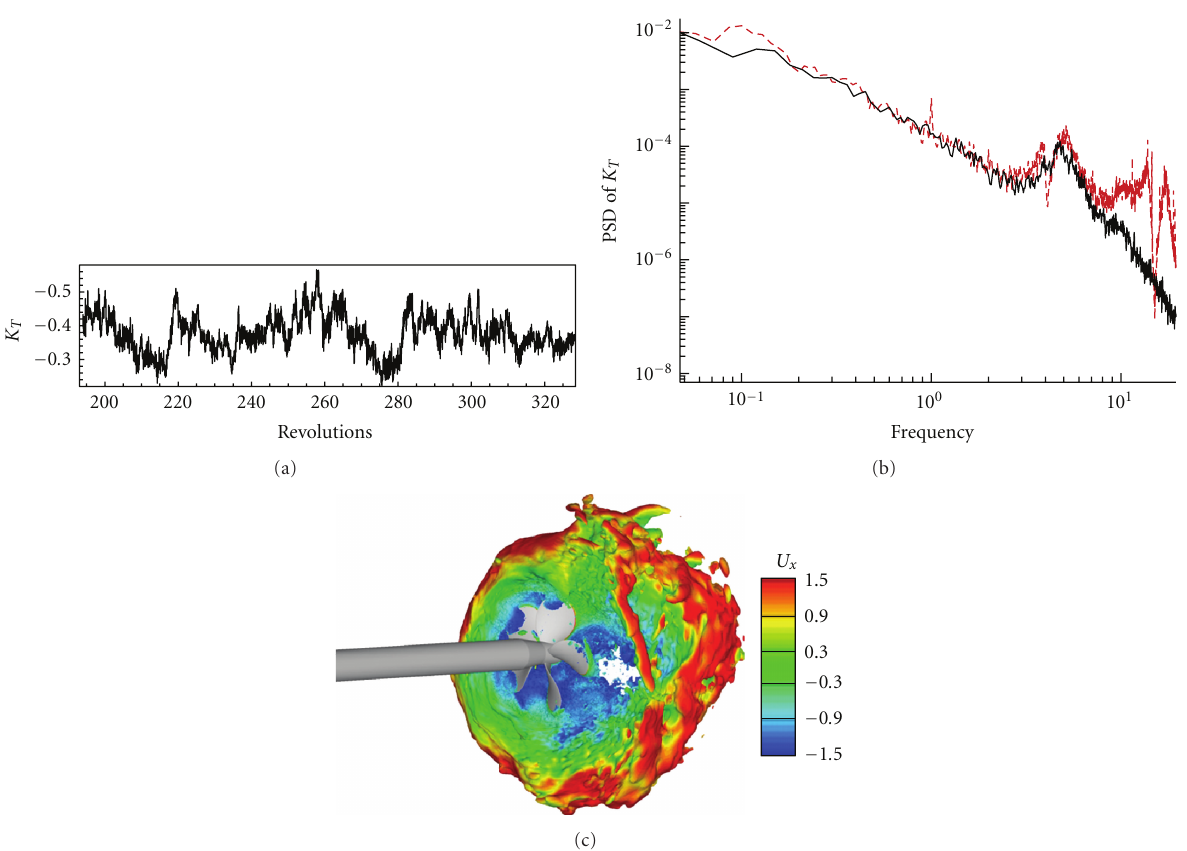
Figure 4: (a) Time history of K T for open propulsor, (b) power spectral density of K T (solid line LES and dashed line WT), (c) instantaneous isocontours of pressure ( C p = − 0 . 5) colored by axial